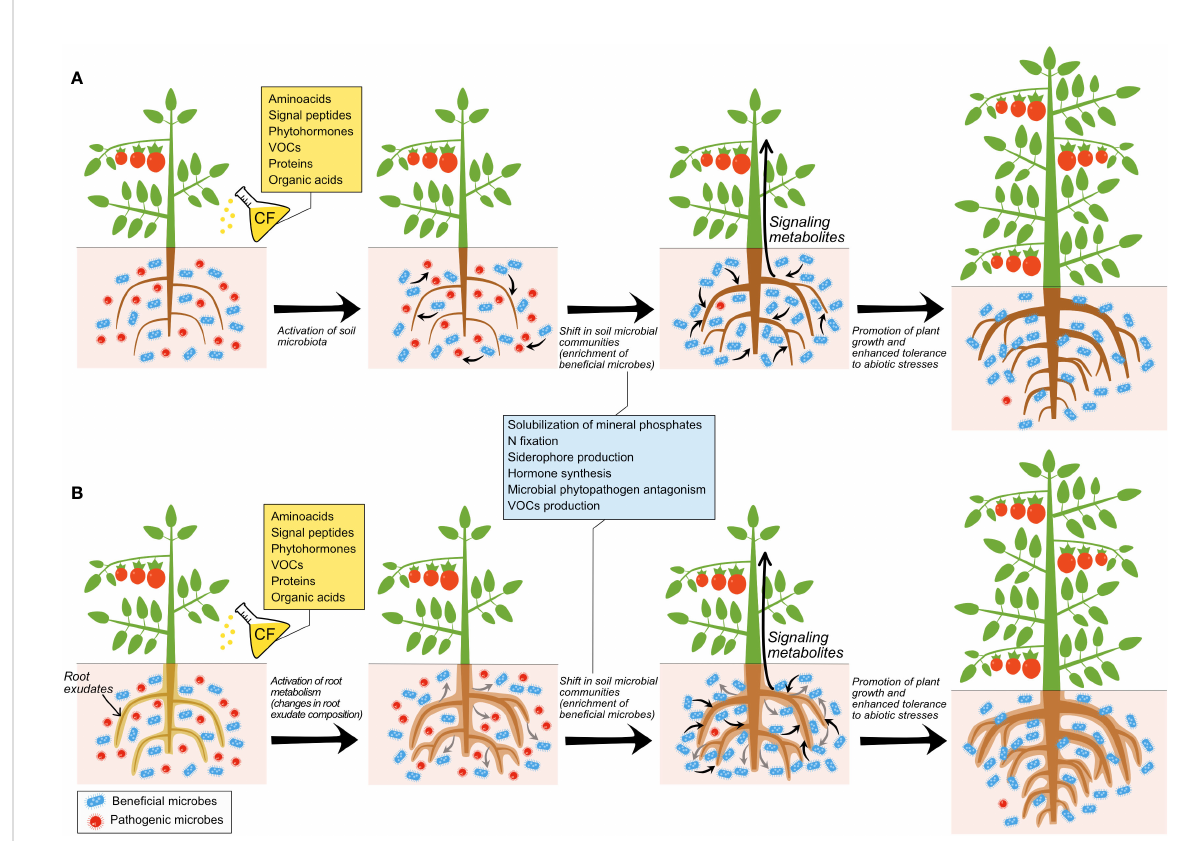
FIGURE 1 Different scenarios of responses of plants and microbiota to soil application of cell-free microbial CFs. (A) illustrates direct action of microbial CF compounds on roots and/or on bene fi cial microorganisms, which release compounds that exert antagonistic effects on pathogenic microorganisms and/or promote plant growth. (B) illustrates direct action of microbial CF compounds on the root exudate composition, which modulates rhizosphere microbiota by impovershing populations of pathogenic microorganisms and enriching those of bene fi cial microorganisms, which in turn promote plant growth and enhance the capacity of plants to adapt to their